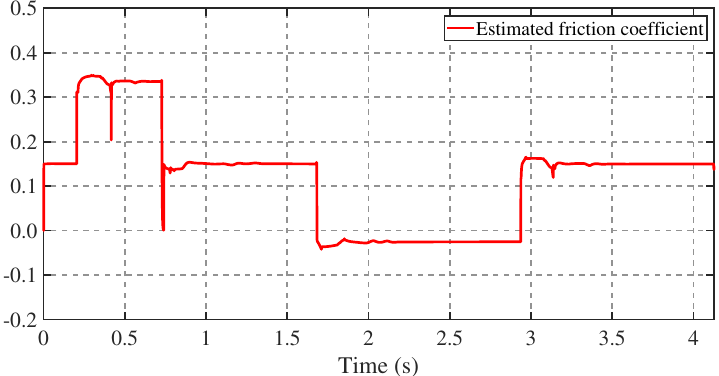
Figure 6. Trajectory of the estimated friction coefficient when the robot slides on uneven